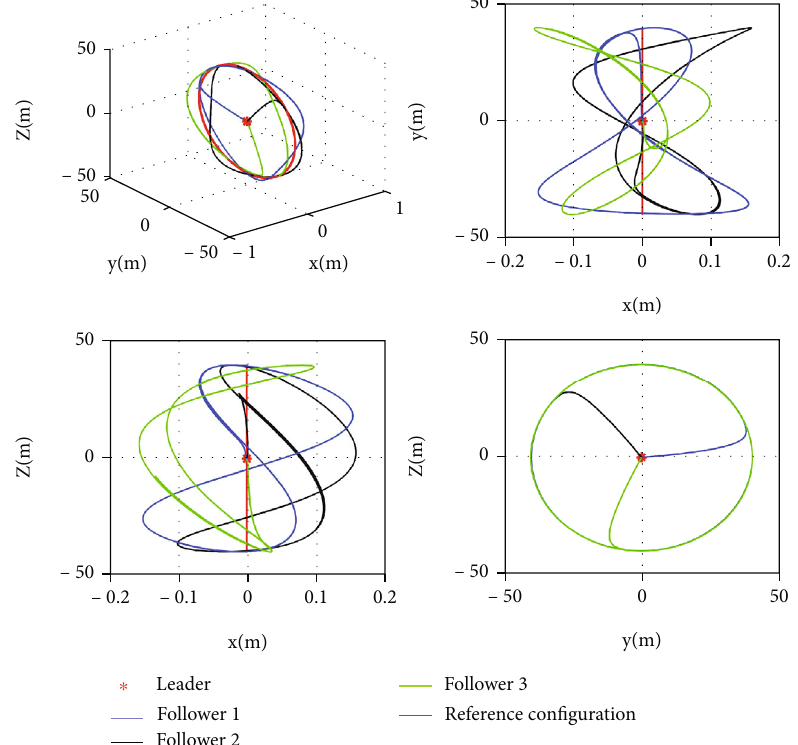
Figure 7: The trajectories of the followers relative to leader